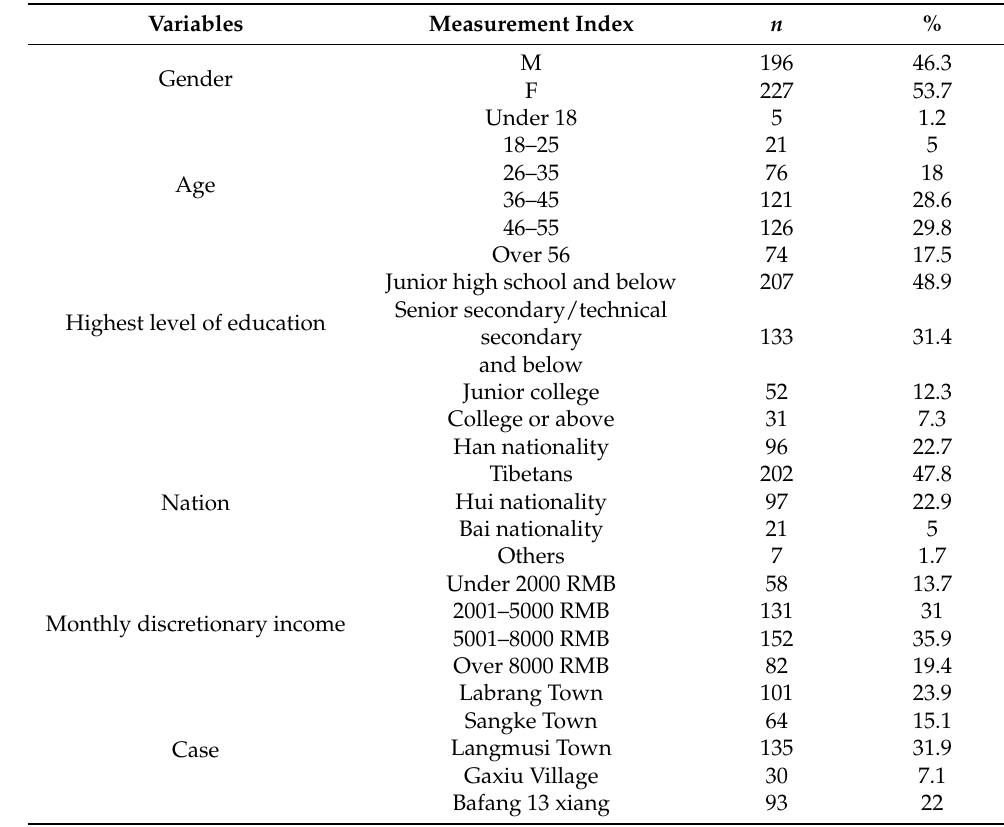
Table 1. Demographic characteristic.